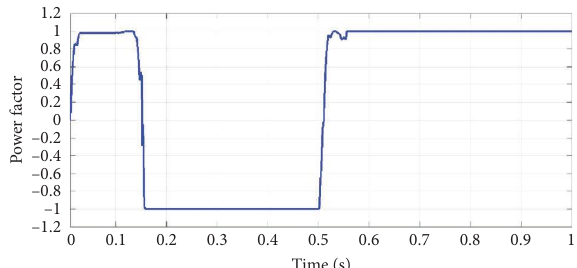
Figure 21: Solar irradiation